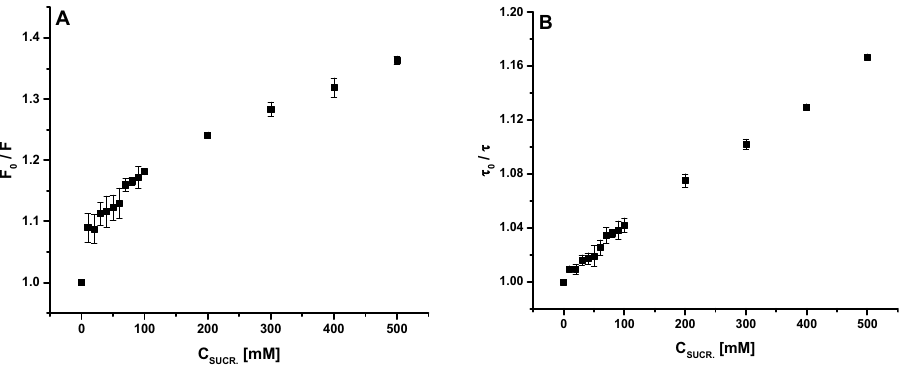
Figure 11. Stern–Volmer plots of CRP in presence of increasing concentrations of sucrose: steady state fluorescence ( A ) and fluorescence lifetime ( B ).